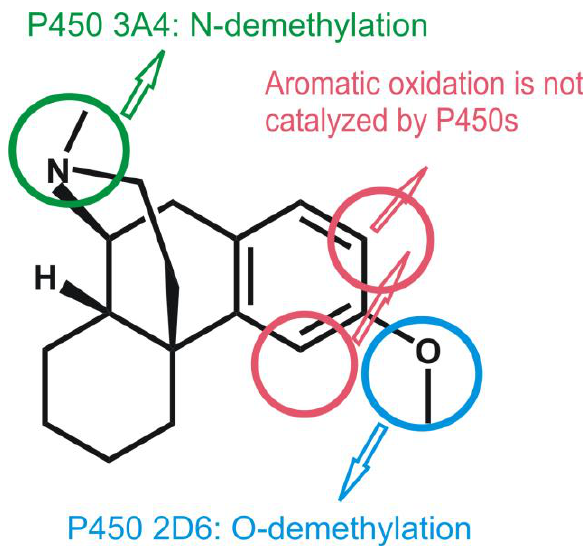
Figure 14. Metabolic routes of dextromethorphan in man as indicated by